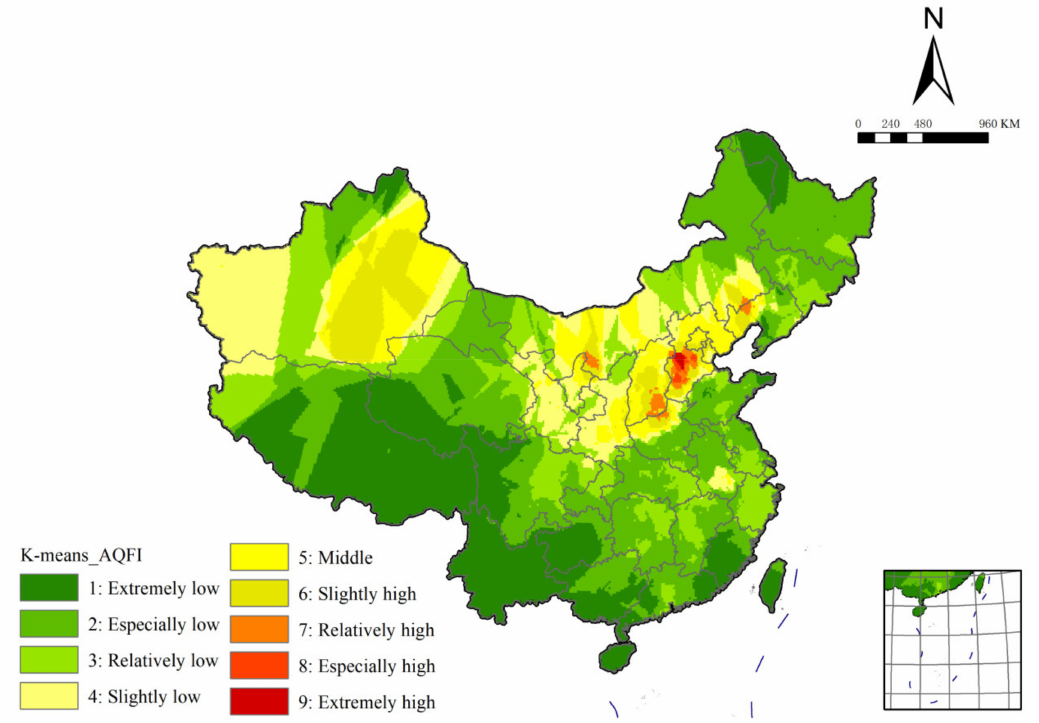
Figure 5. The spatial distribution of K-means